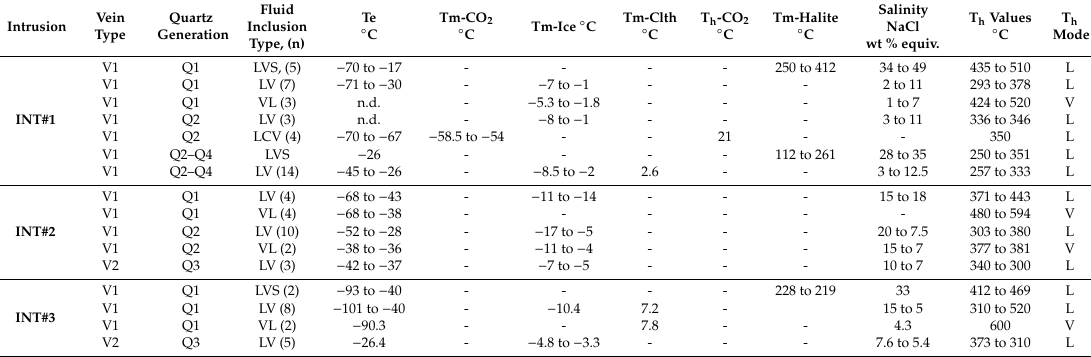
Table 1. Summary of microthermometric results from the di ff erent veins and quartz types of Kı¸slada˘g Au deposit (Te: eutectic temperature; Tm: melting temperature; Clth: clathrate; L: liquid; V: vapor; n: number, n.d. = not